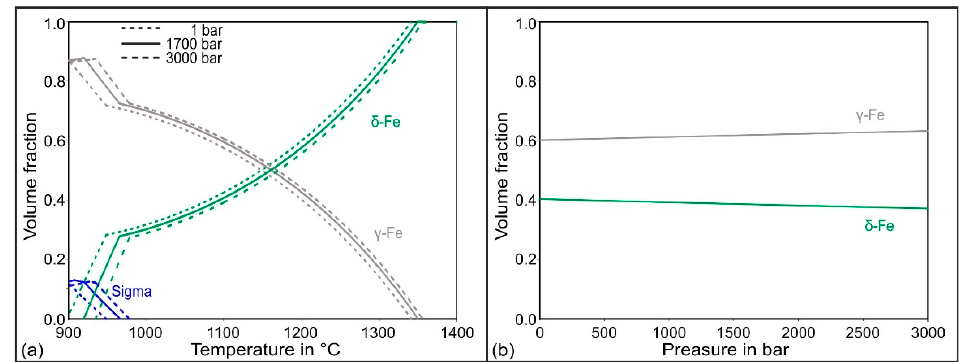
Figure 2. Thermodynamic calculations of the pressure influence on the phase stability during the solution annealing of the steel X2CrNiMoN22-5-3: ( a ) phases over the temperature for 1 bar, 1700 bar, and 3000 bar; ( b ) phases over the pressure.